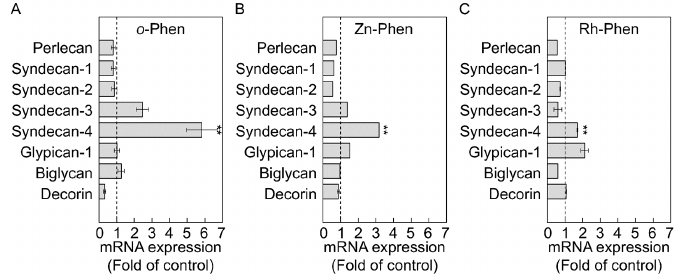
Figure 1. Effects of o -Phen, Zn-Phen, and Rh-Phen on proteoglycan expression in vascular endothelial cells. Bovine aortic endothelial cells were treated with o -Phen ( A ); Zn-Phen ( B ); or Rh-Phen ( C ) at 5 µM each at 37 °C for 24 h and proteoglycan mRNA levels were analyzed by real-time RT-PCR. Values are means ± S.E.M. of four samples. ** p < 0.01 vs. the corresponding control.